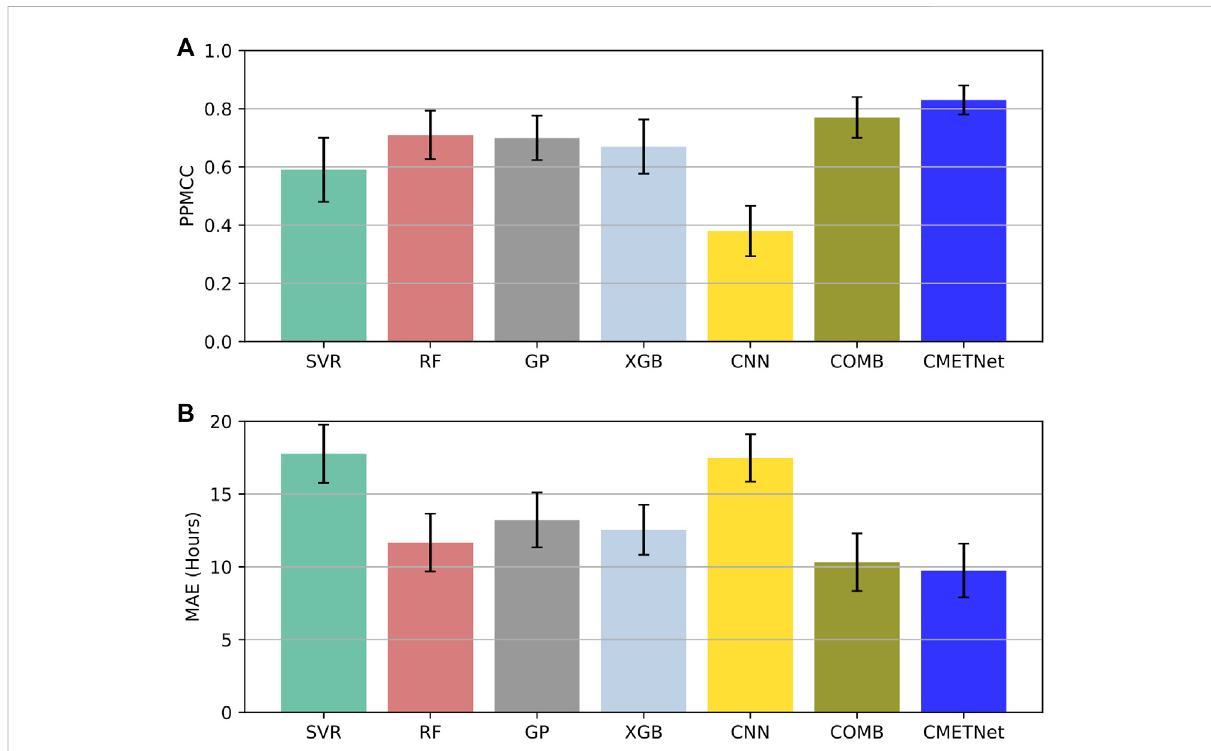
FIGURE 6 Resultsoftheablationtestsforassessingthecomponents(SVR,RF,GP,XGB,CNN)ofCMETNetwhereCOMBistheensemblemodelofSVR,RF, GP and XGB. (A) Pearson product-moment correlation coef fi cients (PPMCCs) of the tested models. (B) Mean absolute errors (MAEs) of the tested models. CMETNet achieves the best performance among all the tested